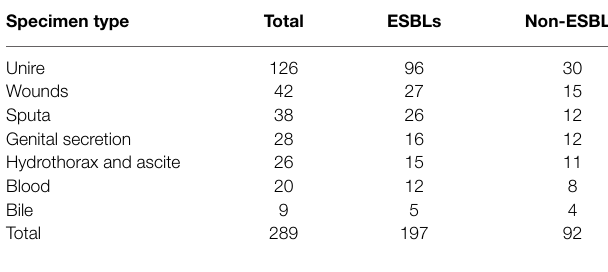
TABLE 3 | Distribution of E. coli Isolates by type of